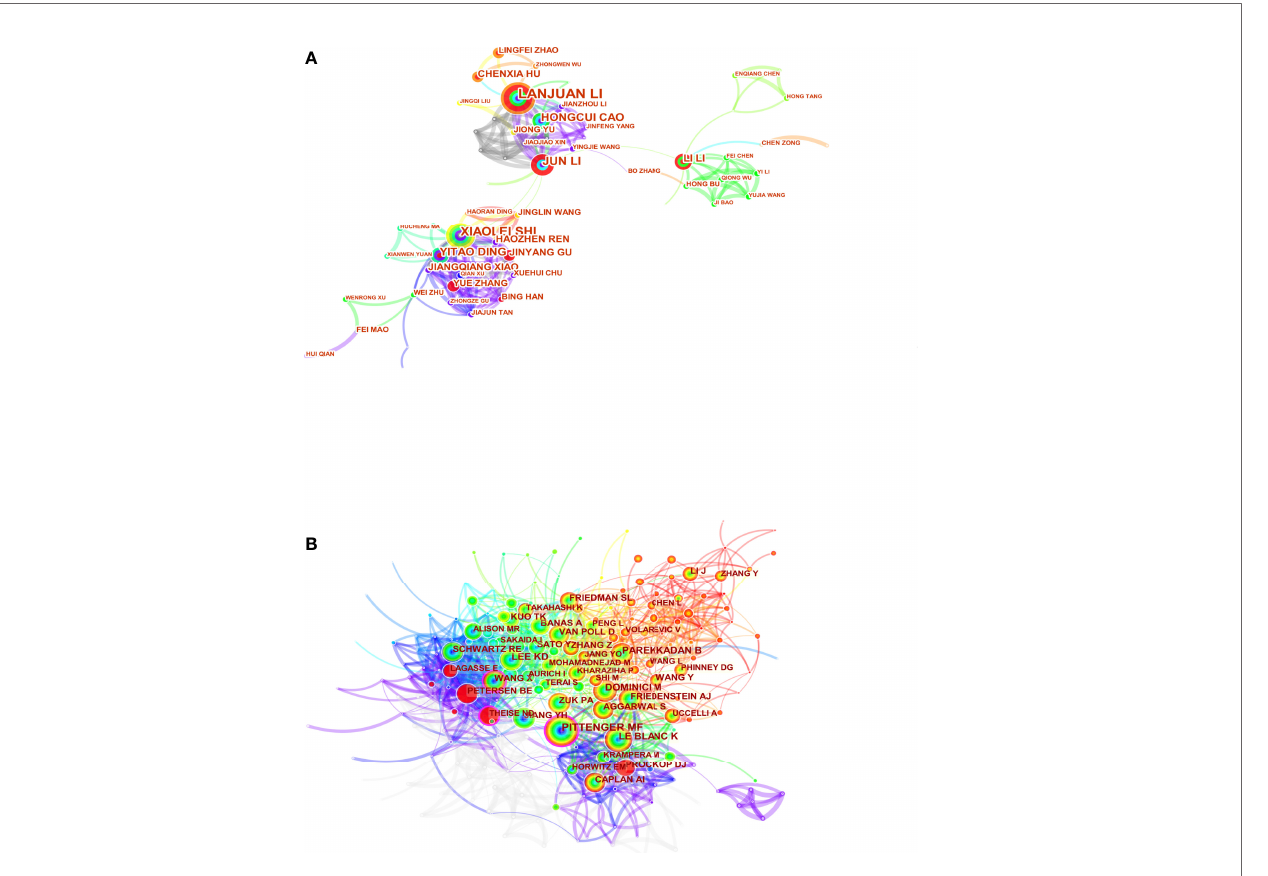
FIGURE 5 | Visual analysis of authors (A) and co-cited authors (B)